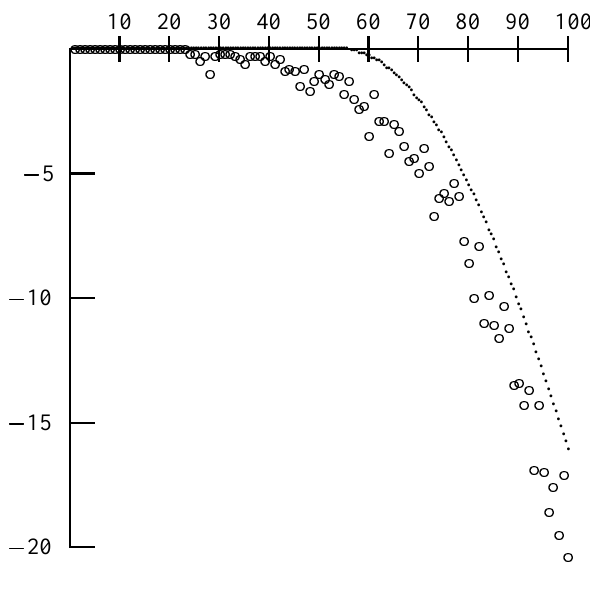
Fig. 2: Average values of D k computed by simulation (circles) and approximated by Theorem 3 (smooth line) terms of the rate 1 continuous time random walk on the symmetric group is: how far from the identity are we at time cn (cid:4)